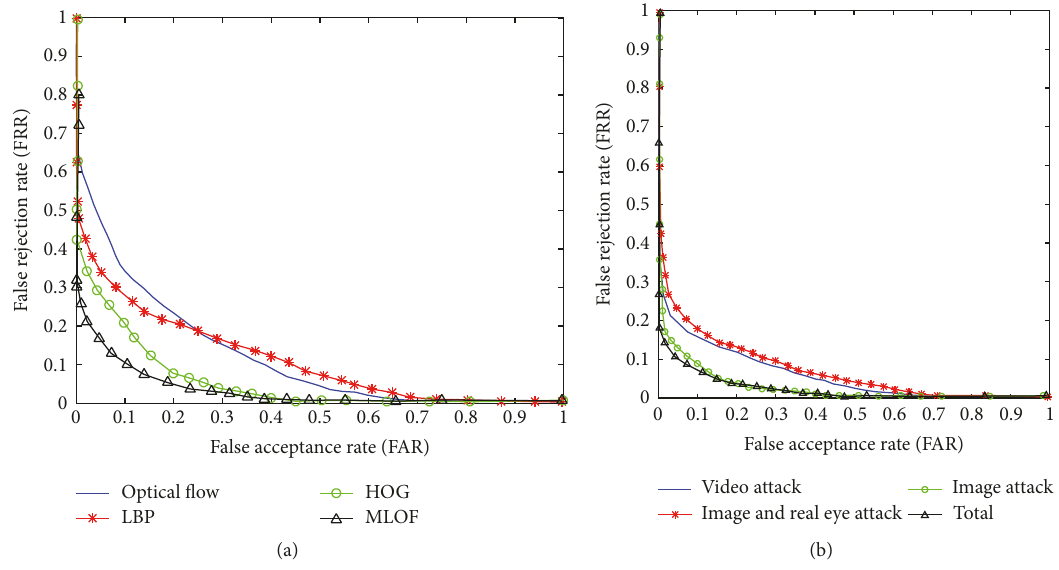
Figure 10: (a) ROC curves of the four algorithms; (b) ROC curve of three ways of attack.